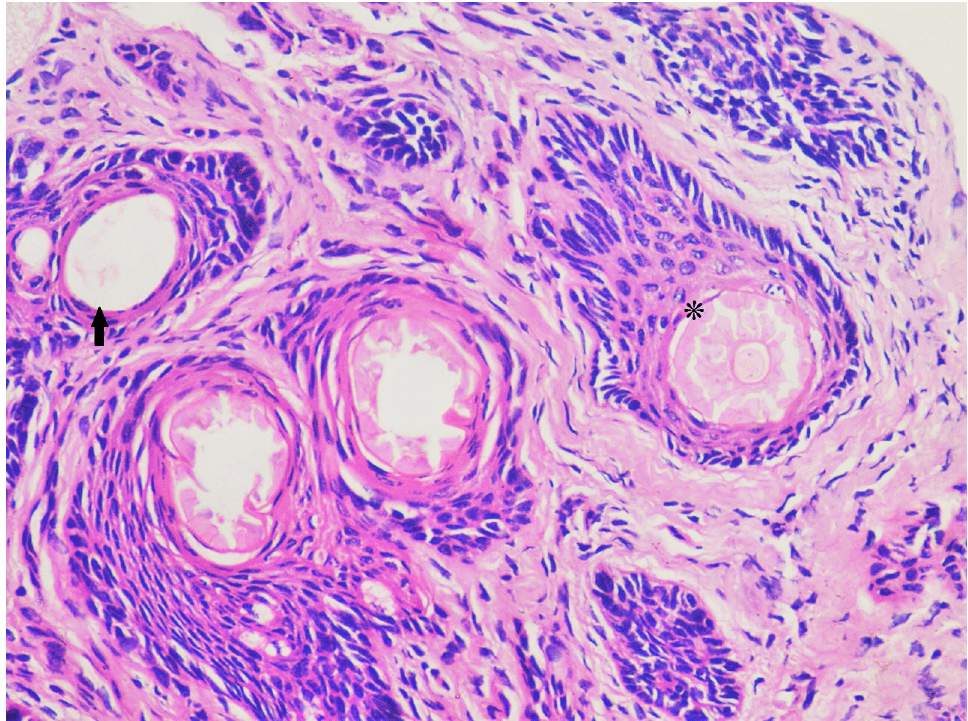
Figure 4: Photomicrograph shows sebaceous gland lobules (*) and epithelial-lined sweat gland (arrow).